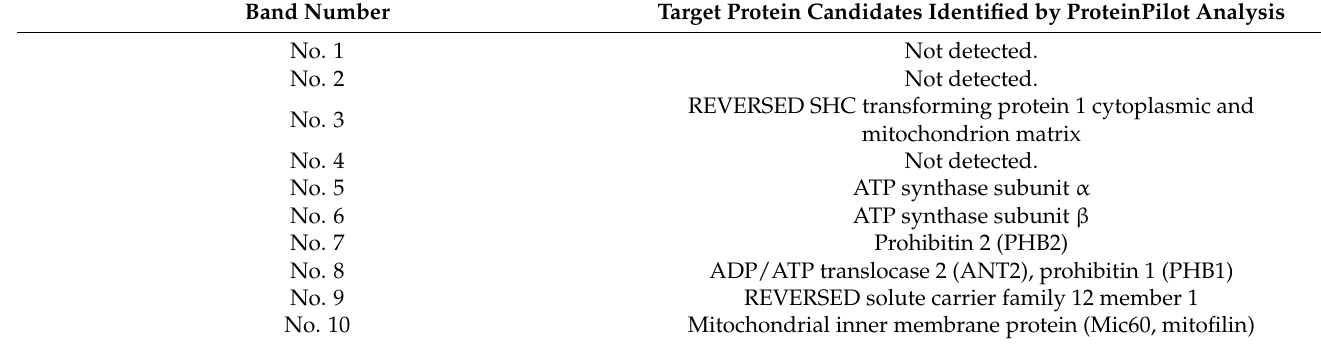
Figure 3. Identification of the binding proteins of kapakahine A. ( A ) Protein bands specifically bound to Kap A-beads ( 6 ) were pulled down from the cytoplasmic protein extract of P388 cells and detected by silver staining. Alkyne beads ( 5 ) were used as the control. The proteins contained in each band were identified by LC/MS/MS analysis. ( B ) Western blotting with antibodies against target protein candidates. PHB1, PHB2, and ANT2 were identified as binding proteins. Table 1. Kapakahine A target protein candidates identified from P388 cells.